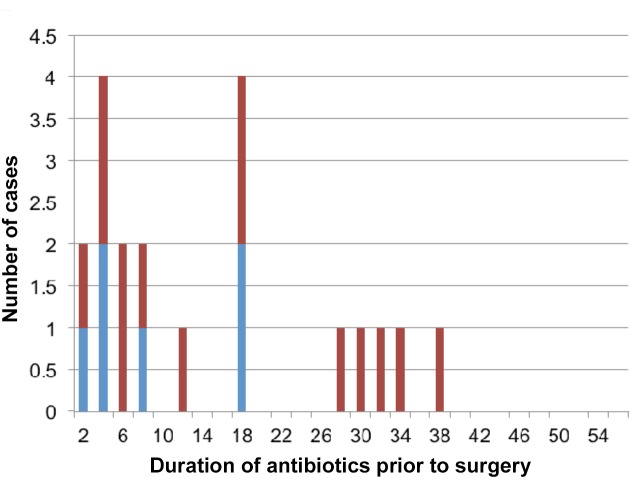
Red column-Negative tissue culture.Blue column-Positive tissue culture.